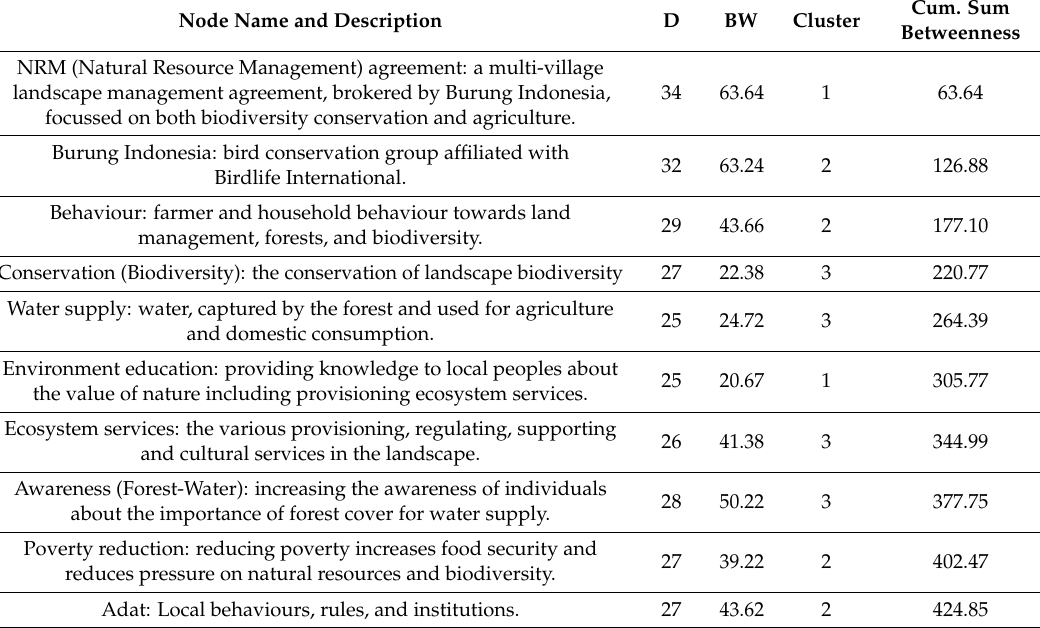
Table 1. Nodes of the Mbeliling landscape food security and biodiversity conservation nexus. Each node has a name and a short description of the node theme. The shaded rows represent the nodes whose cumulative betweenness sums to 50% of the total betweenness. ‘D’ is the degree for each node; ‘BW’ the betweenness value for each node; ‘Cluster’ is the cluster group that each node belongs to; ‘Cum. Sum. Betweenness’ is the cumulative sum of the betweenness of the nodes, ranked by their individual betweenness values. Cum. Sum Node Name and Description D BW Cluster